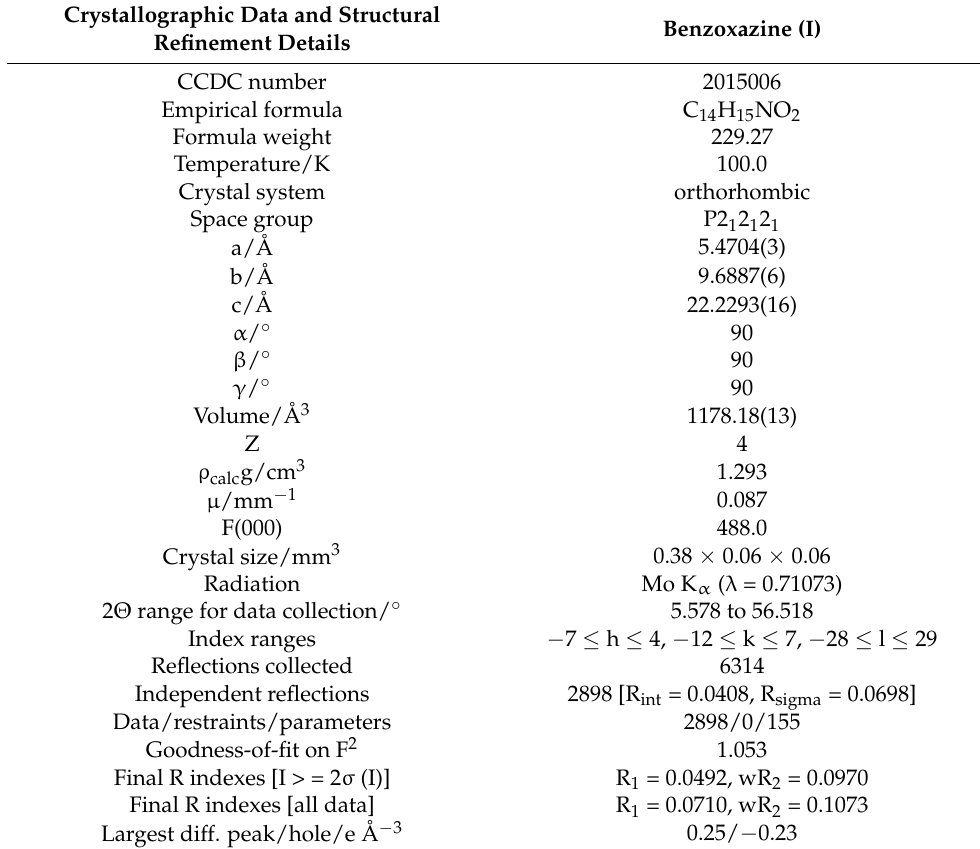
Table 1. Crystal data and structure refinement details for the benzoxazine